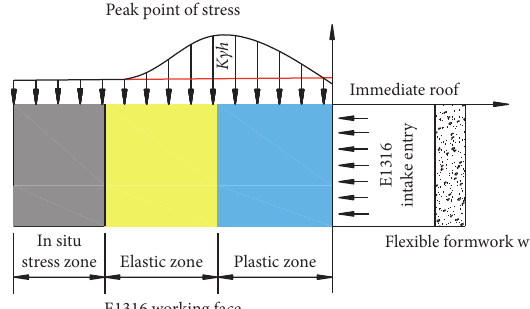
Figure 21: The diagrammatic sketch of stress distribution in coal pillar